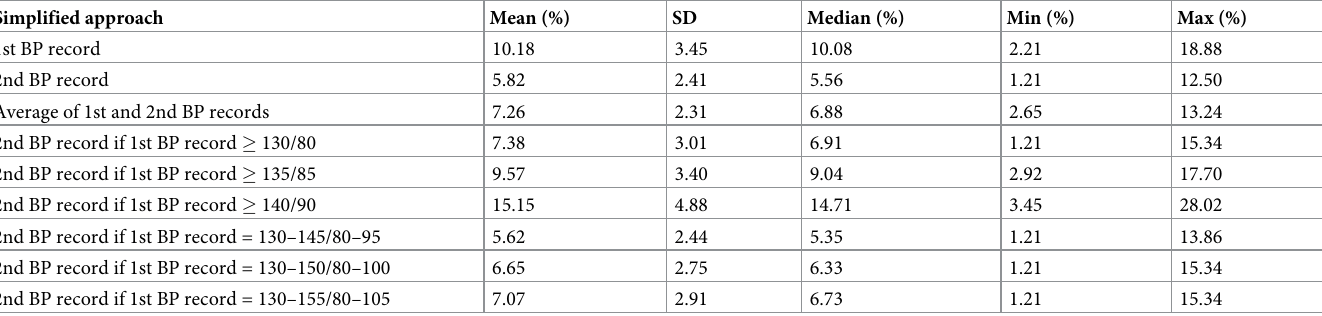
approaches. Conversely, using the second BP reading if the first BP measurement is � 140/90 mm Hg does not appear to be a reasonable option because it yields large misdiagnosis rates. Over-diagnosis Globally (S2 Table), as well as across the 6 regions (S3 Table), the simplified approach with the smallest over-diagnosis proportion was using the second BP reading if the first BP measure- ment was � 140/90 mm Hg. Globally, this proportion was 3.03%; across regions this Table 2. Proportion (%) of missed hypertension cases for each of the 9 simplified approaches: Global results. Simplified